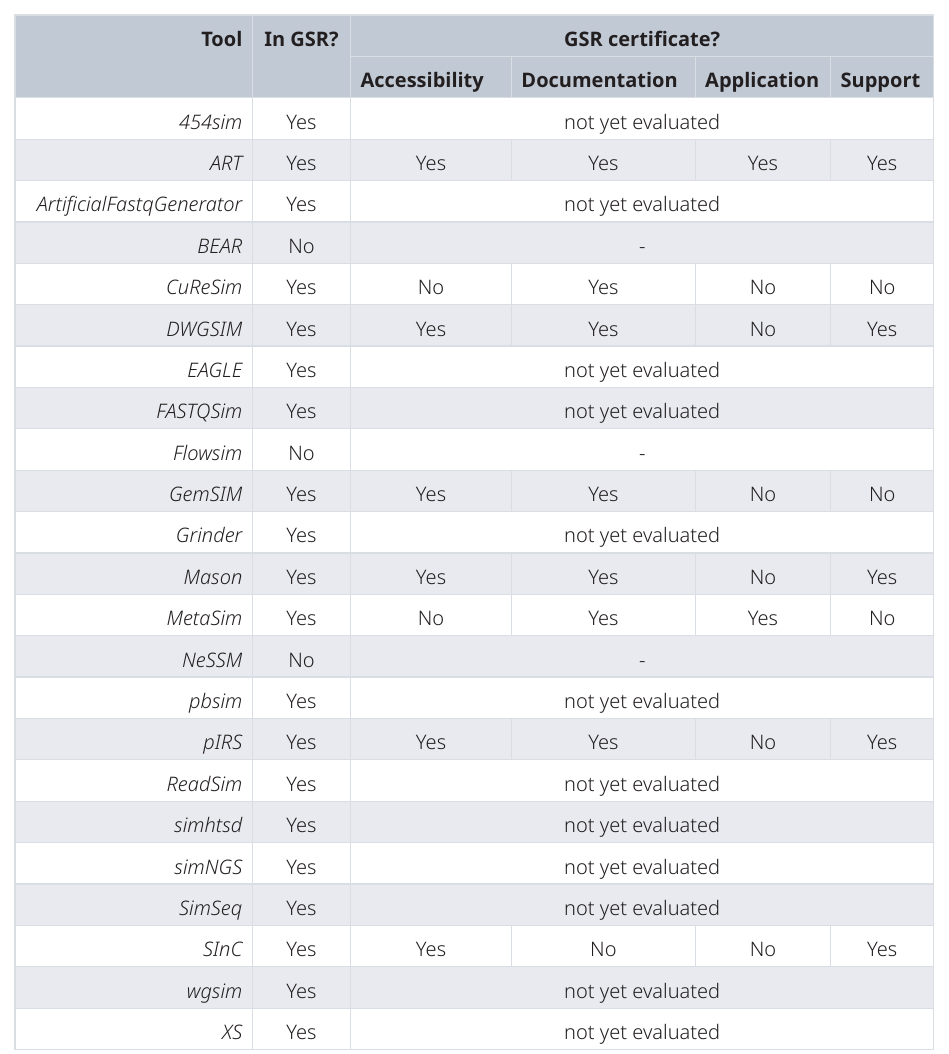
Table 1. Analysis of the GSR certifications of the computational tools for the simulation of next-generation sequencing described in 48. See text for